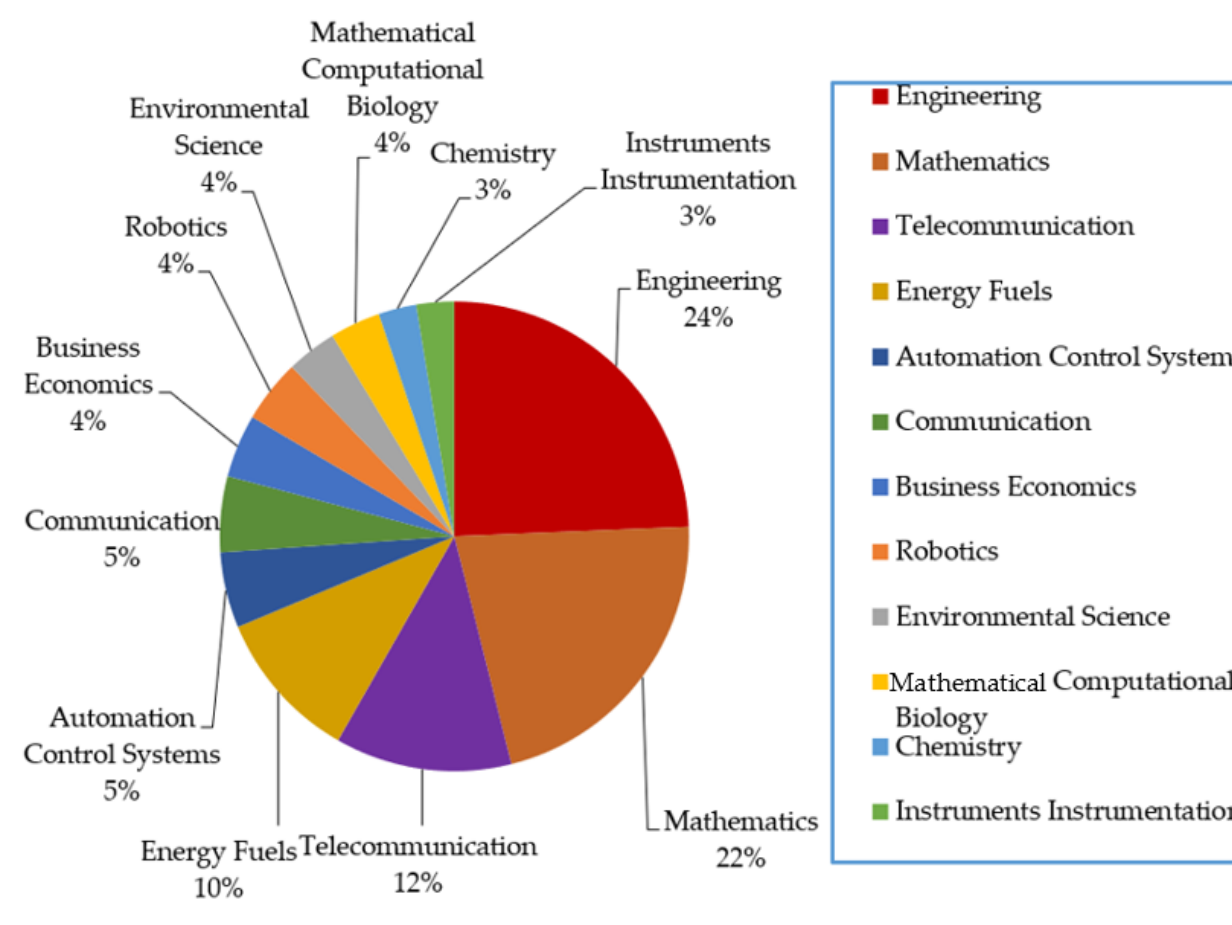
Figure 1. Related MS publications since 2018.